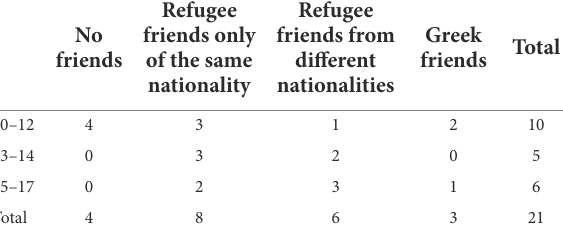
TABLE 5 Refugee children’s friendship patterns and formal school